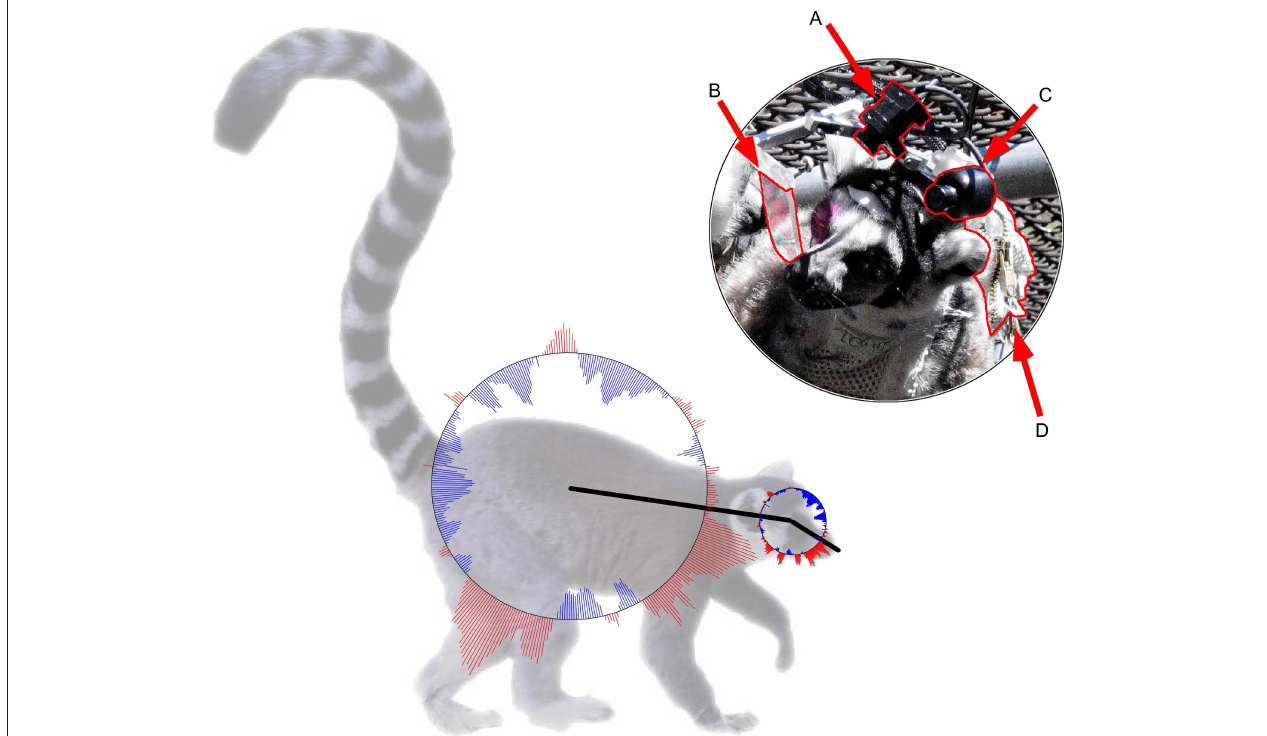
FIgure 3 | Lemurs use deictic social cues to guide naturalistic orienting. Upper: New technologies permit human and nonhuman gaze to be recorded during naturalistic interaction. These techniques can reveal subtle patterns of signaling which are difficult to detect in the field or evoke in the laboratory. Michael Platt and I recorded infrared video (A) of a lemur’s eye, as reflected in a dichroic mirror (B) , while simultaneously recording (C) the scene in front of the lemur and transmitting (D) both data sets to a computer for extraction of gaze